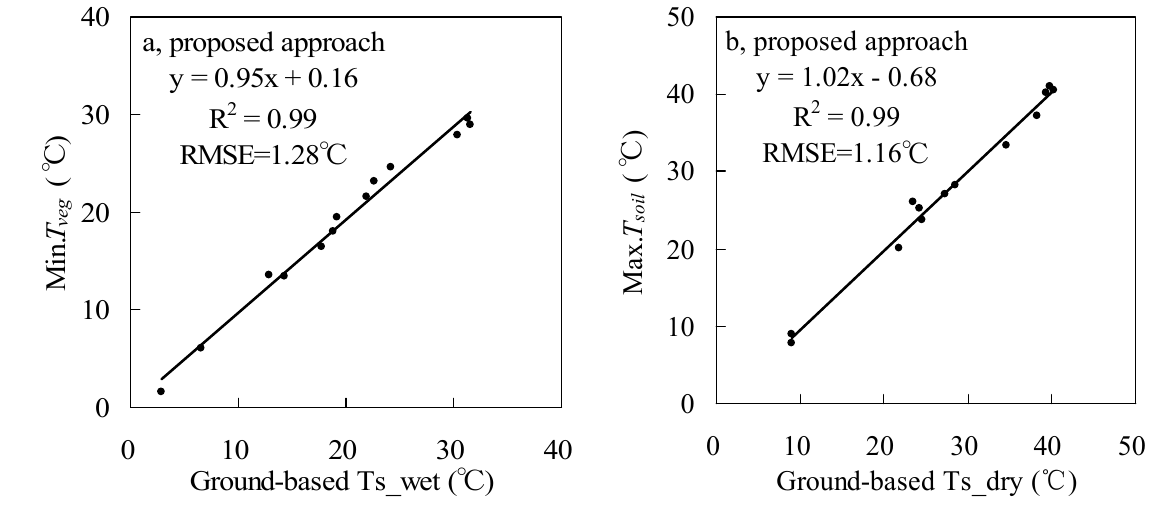
Figure 6. Comparisons of (a) the minimum MODIS-T with ground-based Ts_wet, and veg with ground-based Ts_dry across the whole year of 2003. (b) the maximum MODIS-T soil